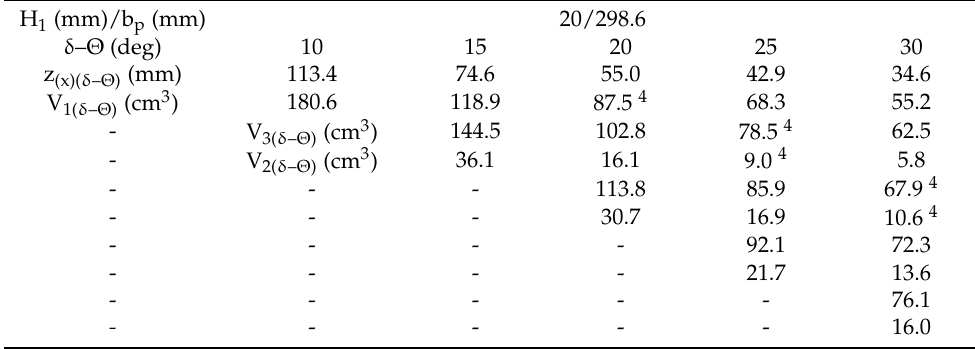
Table 4. Volume of material V i( δ – Θ ) [cm 3 ] for H 1 = 20 mm belt cleat.